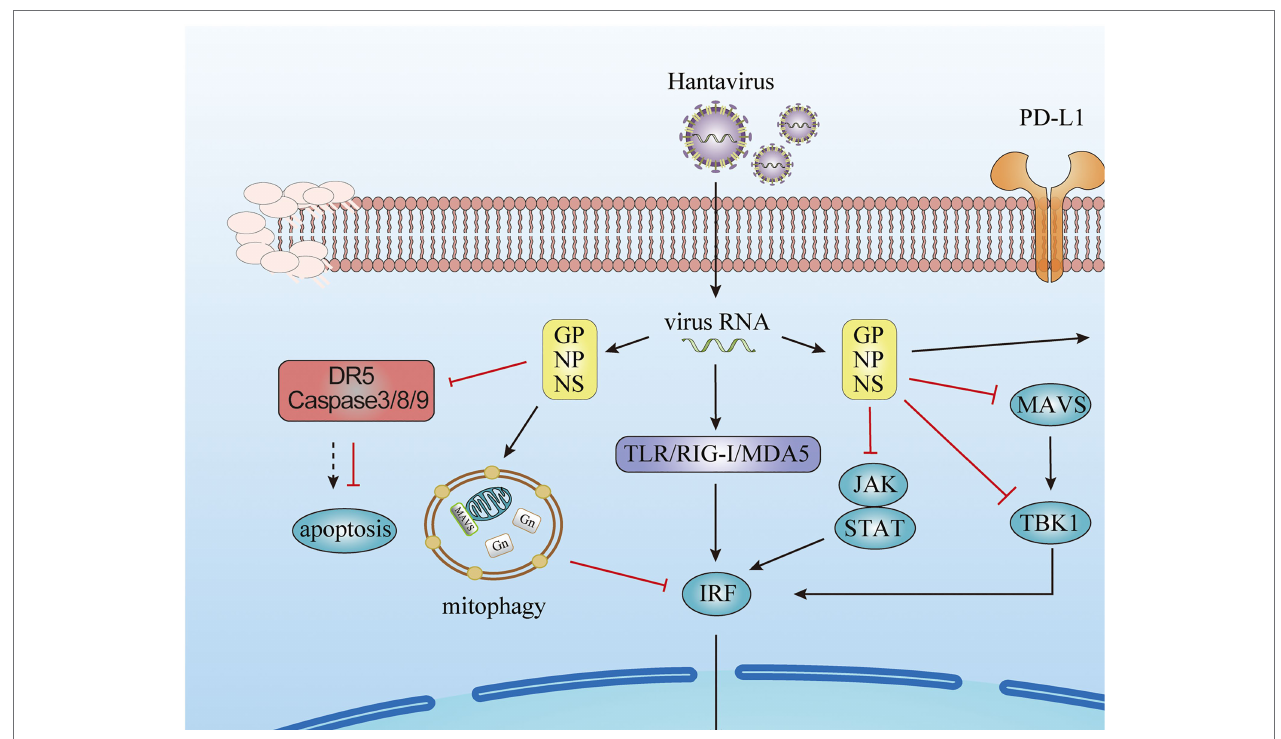
FIGURE 1 | Evasion of the innate immune response by hantavirus. Viral proteins from hantavirus evolving escape strategies involving the inhibition of Interferon (IFN) signaling pathways, the prevent on the host cell apoptosis, the production of microRNA, and the increasing of immune check point